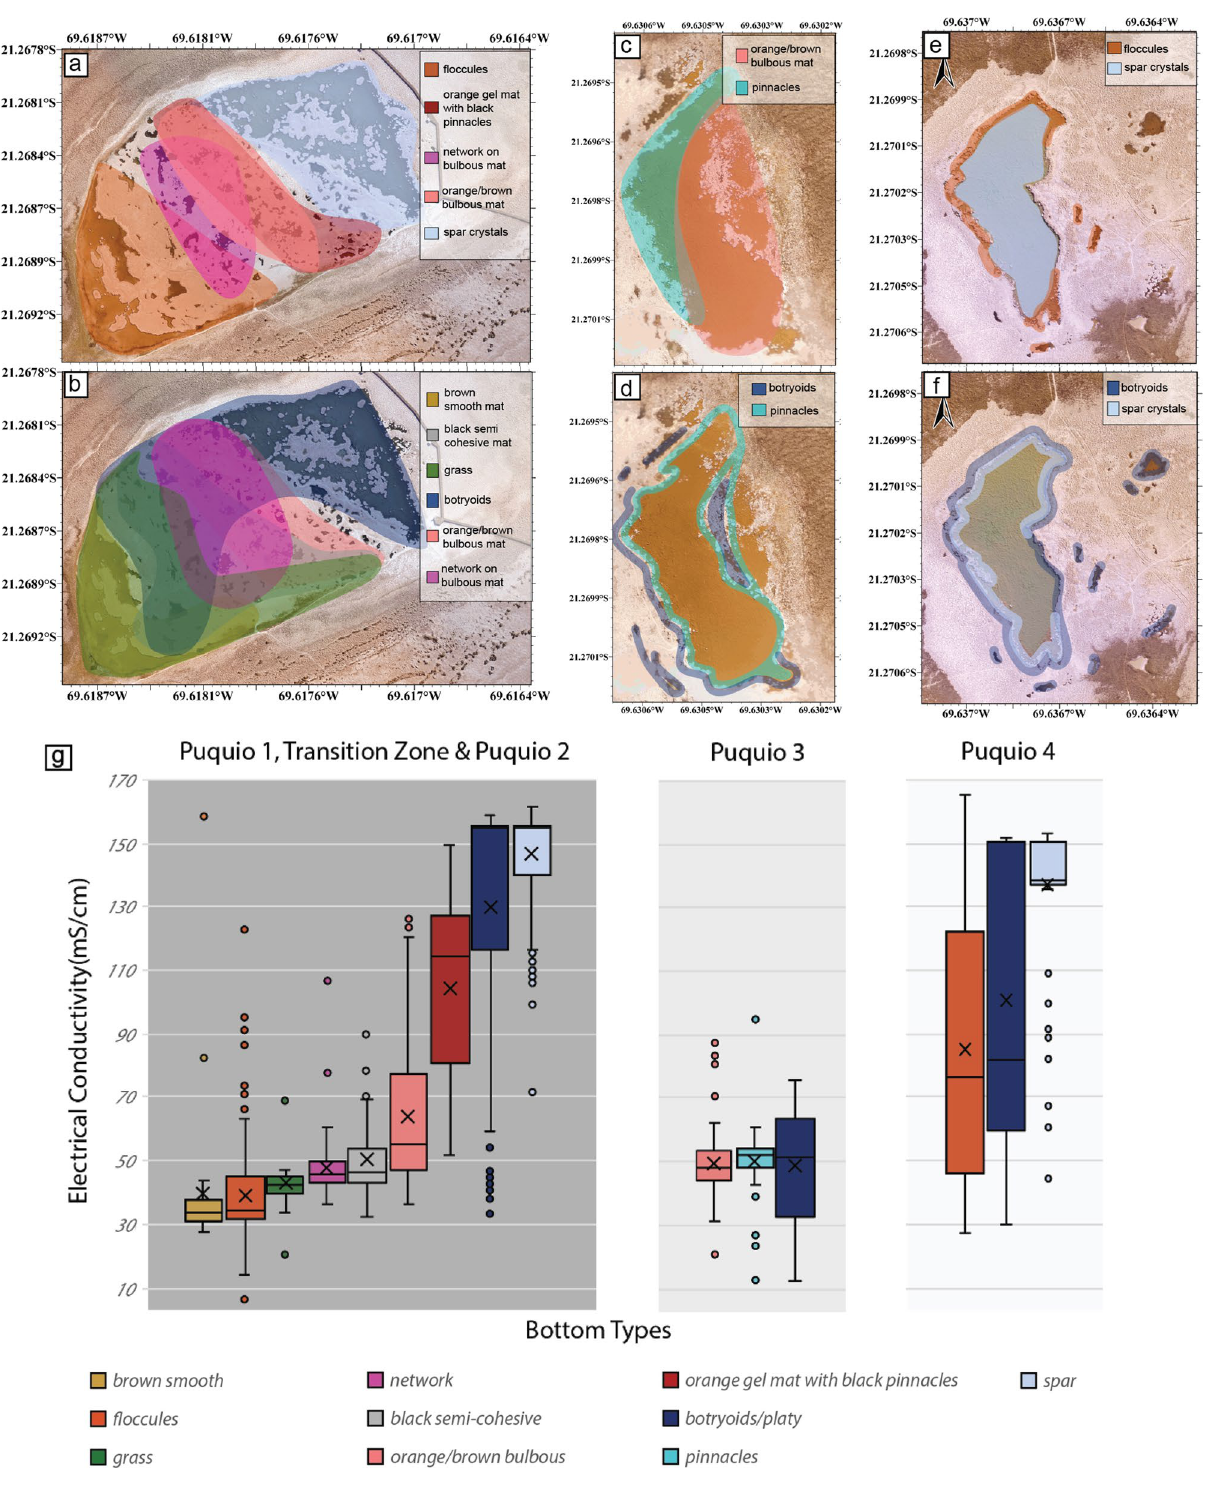
Figure 5. Generalized maps showing geographic trends of principle bottom types (PBT), generated from individual point maps (Supplemental Fig. S6). General location of dominant ( a ) bottom surfaces and ( b ) side wall surfaces for Puquios 1 and 2; general location of dominant, ( c ) bottom surfaces and ( d ) side wall surfaces for Puquio 3; general location of dominant, ( e ) bottom surfaces and ( f ) side wall surfaces for Puquio 4. Maps were generated in Global Mapper v20.1 https:// www. bluem arble geo. com/. Zones were traced using data from Supplemental Fig. S6 using Adobe Illustrator 2021 https:// www. adobe. com/ produ cts/ illus trator. html. ( g ) Box and whisker plots showing the correlation of bottom and side types with electrical conductivity in